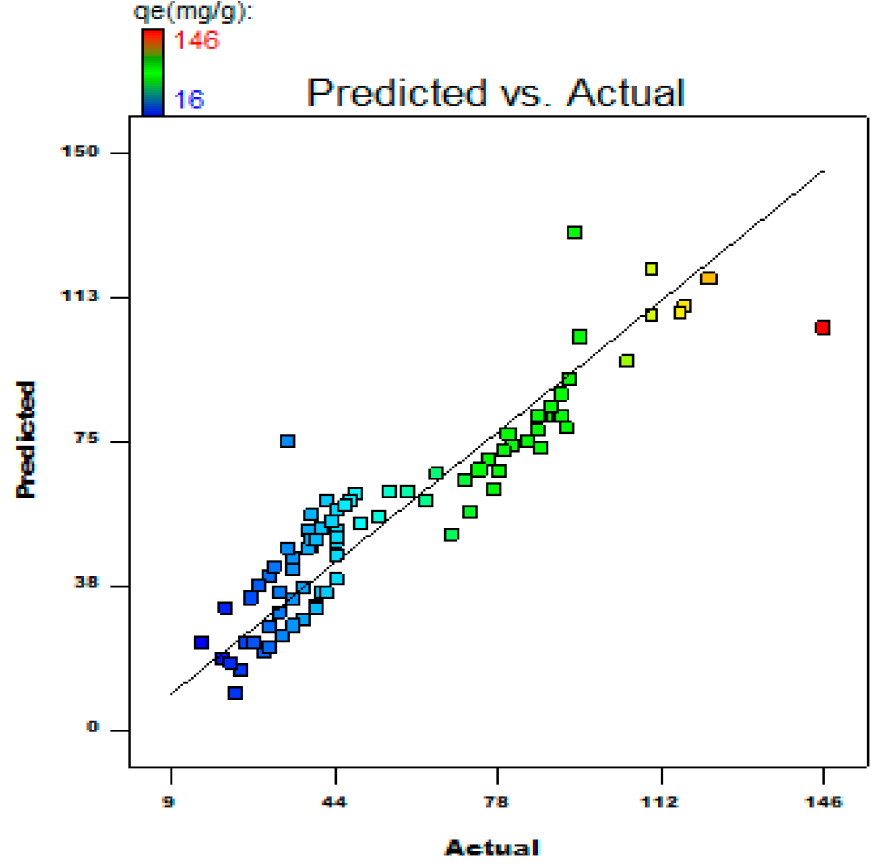
Figure 11. Actual versus predicted values of BG-HNT.